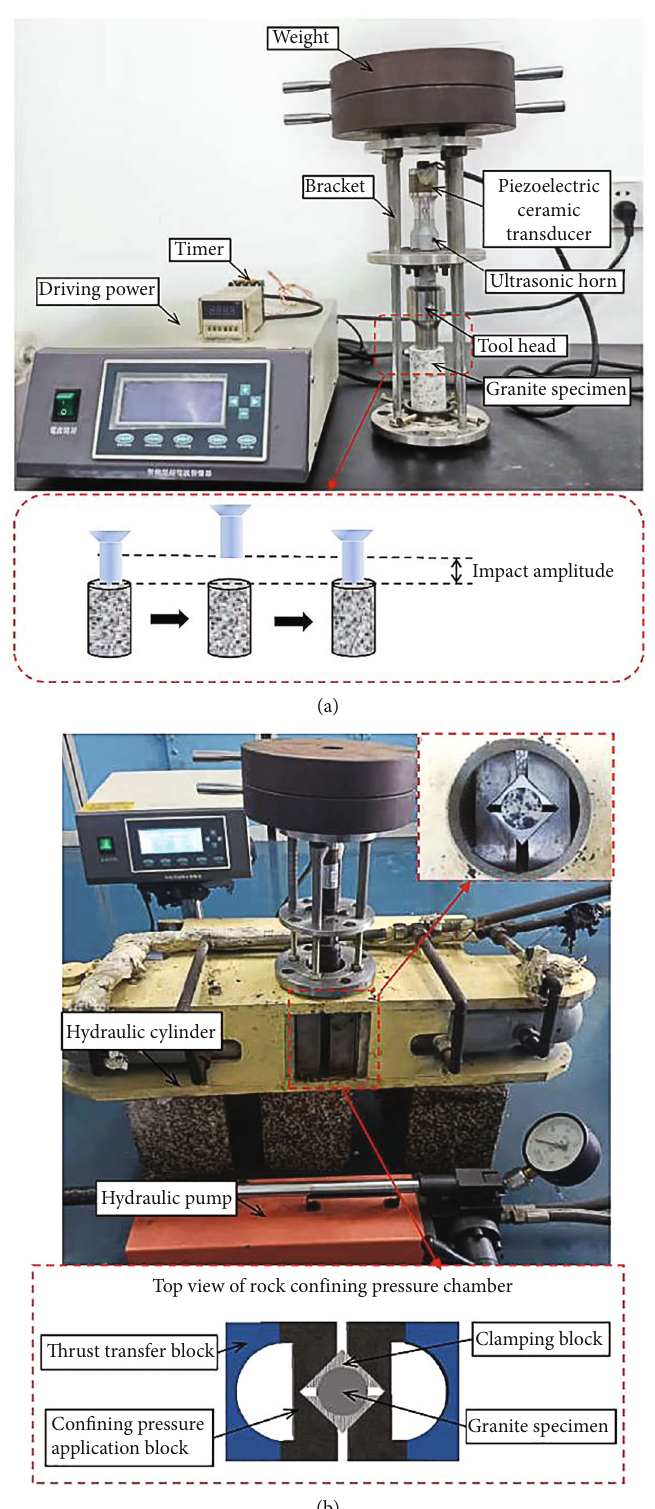
Figure 1: Ultrahigh impact test device: (a) uniaxial ultrahigh impact device; (b) triaxial ultrahigh impact test